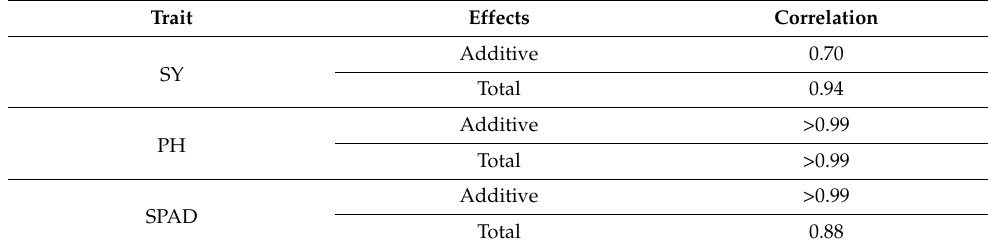
Table 2. Residual maximum likelihood estimates of the between environment (watering block) genetic correlations for Additive and Total (additive plus non-additive) effects of each trait from the baseline factor analytic linear mixed model with markers. Correlations are presented only for SY, PH, and SPAD, for which the two blocks were considered as two environments in the analysis; SY: Seed yield,